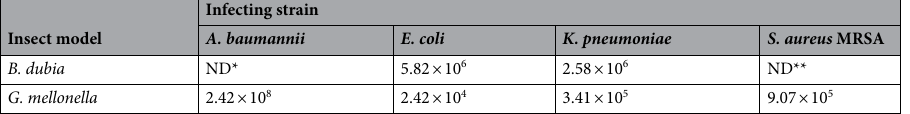
Table 1. LD50. ND not determined. *50% lethality not produced with highest dose of 6.5 × 10 7 bacteria